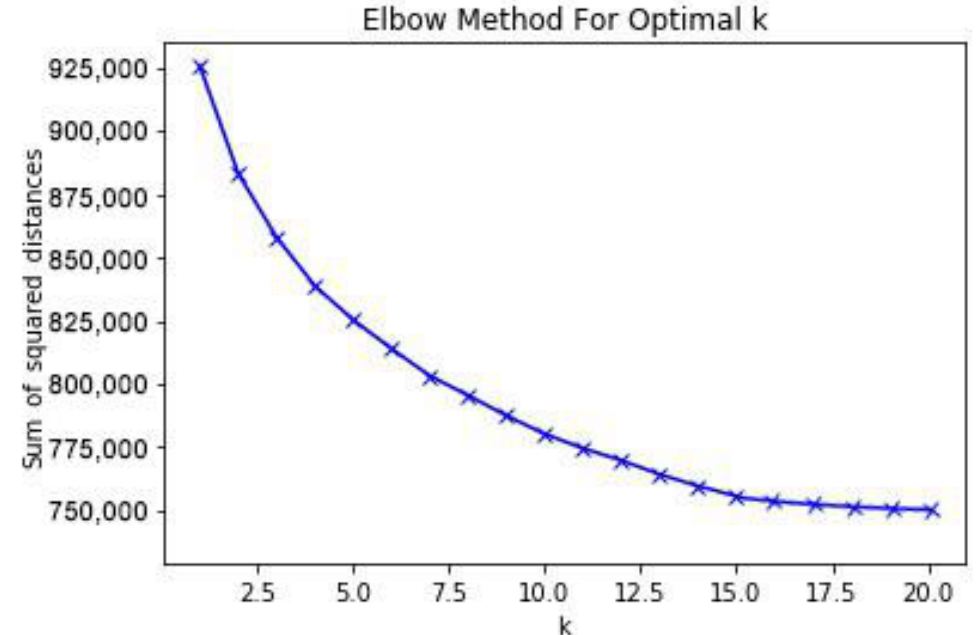
Figure 4. Elbow method to determine the optimal clusters K.